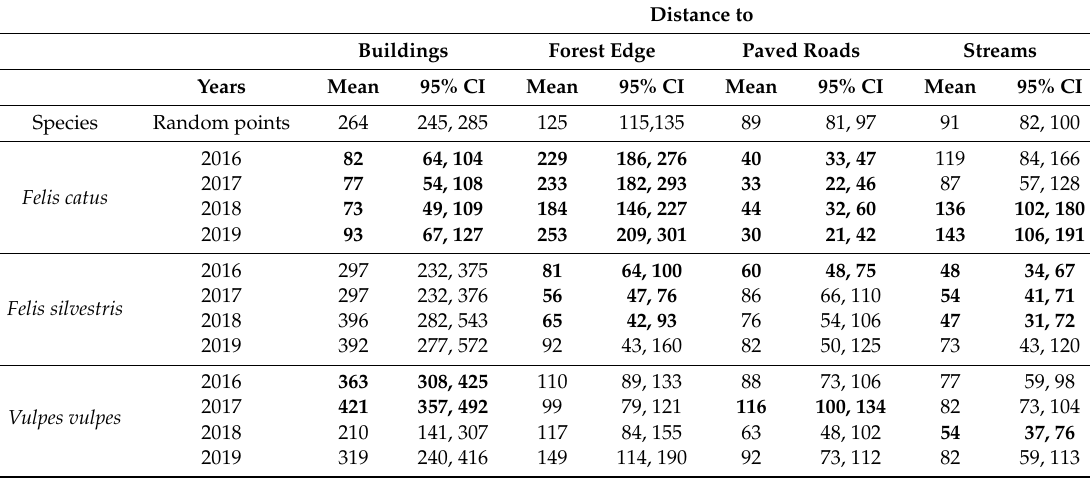
Table 2. Distance of observed European wildcats, domestic cats and red foxes to di ff erent environmental features in pastures for each study year. Distances from random points to these same environmental features are also shown. All results are in meters. Bold results indicate significant di ff erences between observed and random distances. Distance to Buildings Forest Edge Paved